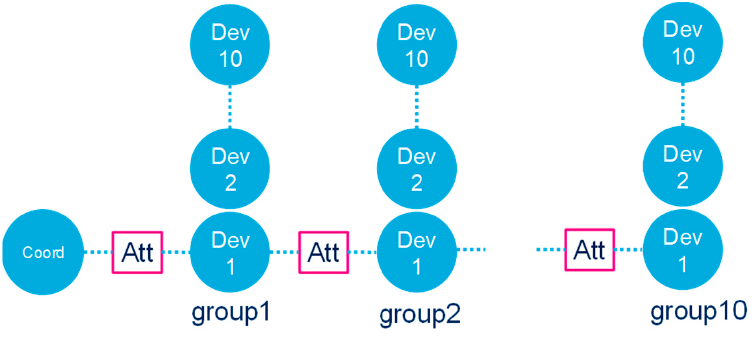
Figure 10. Network topology for testing the RREQ jittering mechanism.